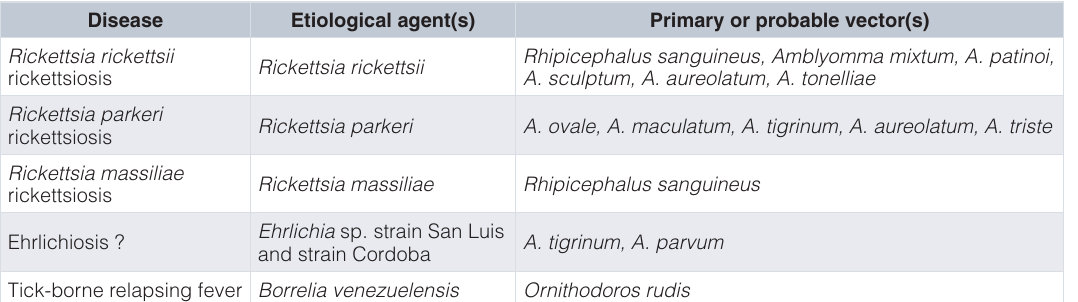
Table 1. Examples of selected tick-borne diseases in Latin America.